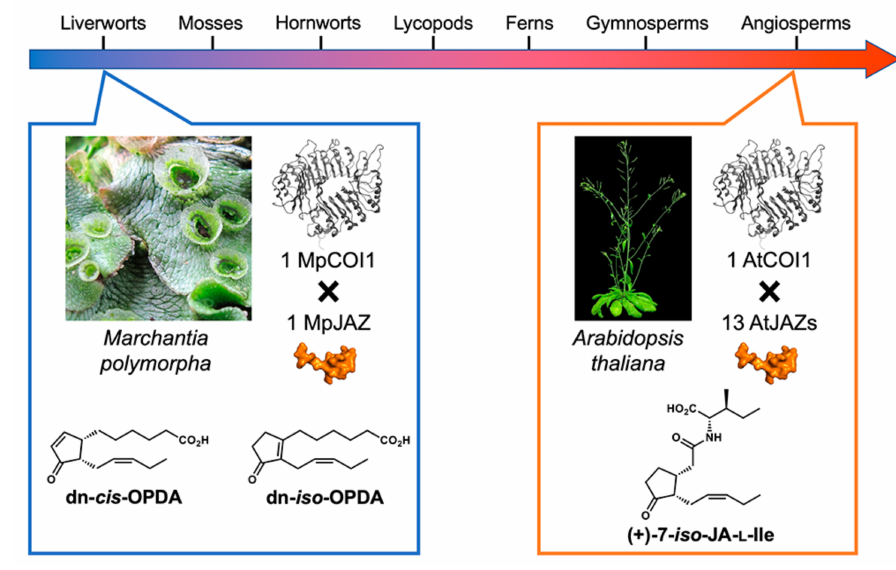
Figure 6. Ligand-receptor coevolution in jasmonate signaling.